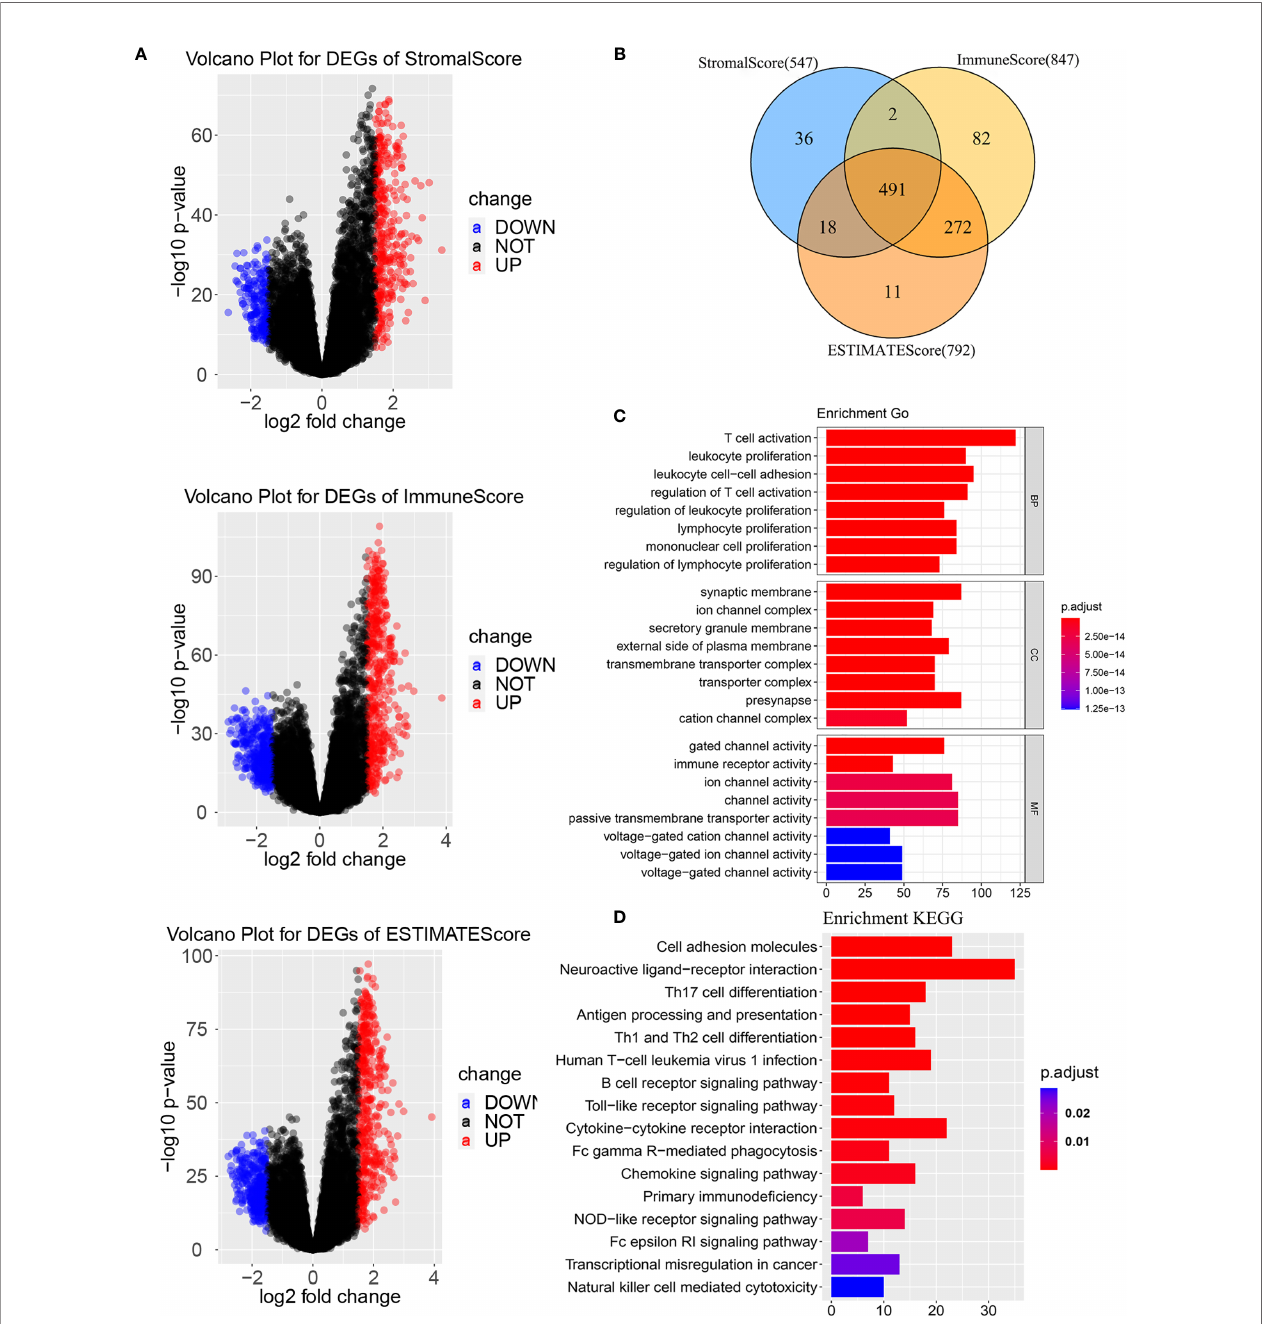
FIGURE 2 | Differentially expressed genes based on tumor microenvironment (A) Volcano Plots for DEGs. (B) Venn diagram. (C) GO enrichment analysis of the DEGs. (D) KEGG enrichment analysis of the DEGs. BP, biological process; MF, molecular function; CC, cellular component. GO, Gene Ontology; KEGG, Kyoto Encyclopedia of Genes and